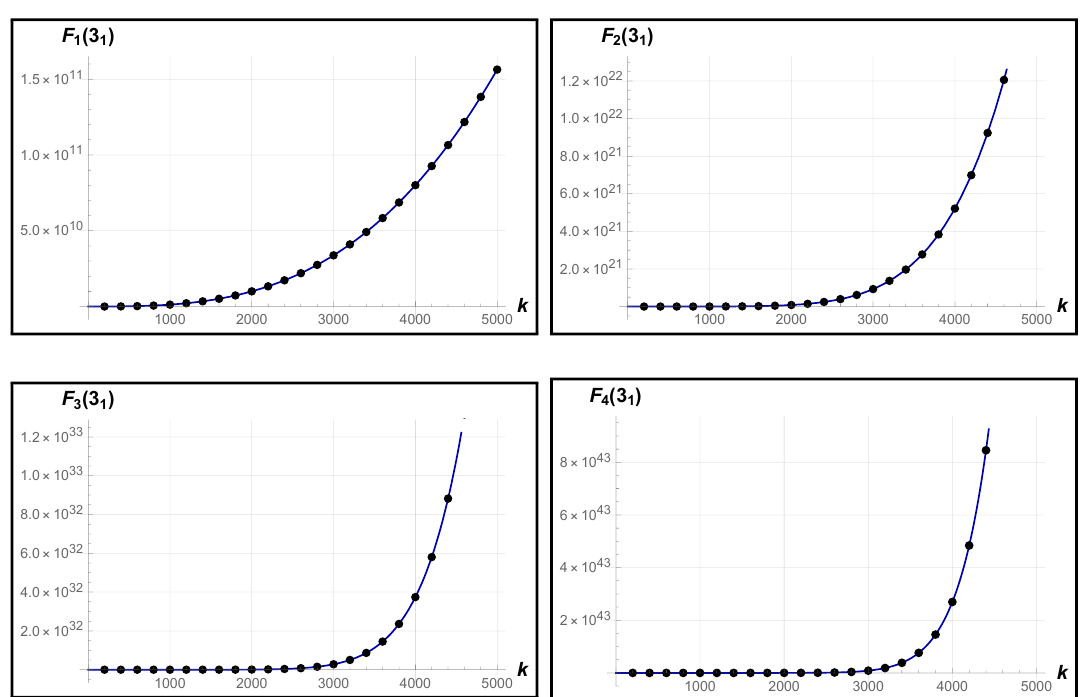
Figure 5. The variation of the function F m with k for 3 1 knot. The solid line denotes the function C m k 3 m with values of C m given in table 2. The • indicates the values of F m obtained from explicit computations using